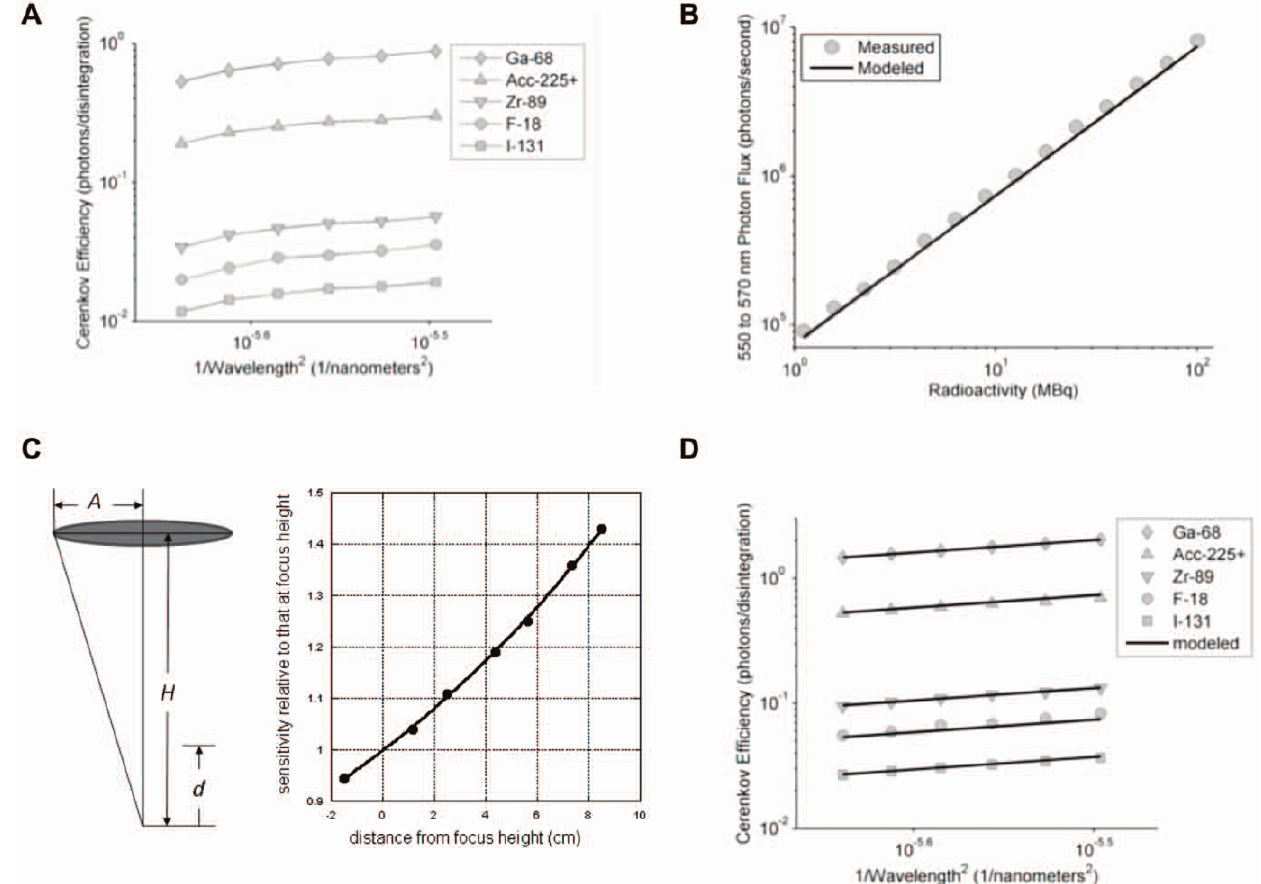
Figure 1. Evaluation and Correction of Luminescence Imaging System for CR. A) The CR efficiency measured as a function of one over the photon wavelength squared using calibrations provided by the manufacturer. These plots should be linear. B) Test of the linearity of the photon flux measurements. C) The diagram depicts the lens of the luminescence imager (gray ellipse) and defines the parameters used in expression (4). Plot on right shows the measured camera sensitivity as a function of the height of the imaged object (dark circles) along with a fit of expression (3) to determine the value for parameter H (which was otherwise difficult to measure directly). D) Same data as in (A) but now after calibrations based on our model and the spectral measurements for Ga-68. All measured spectral data are now very close to